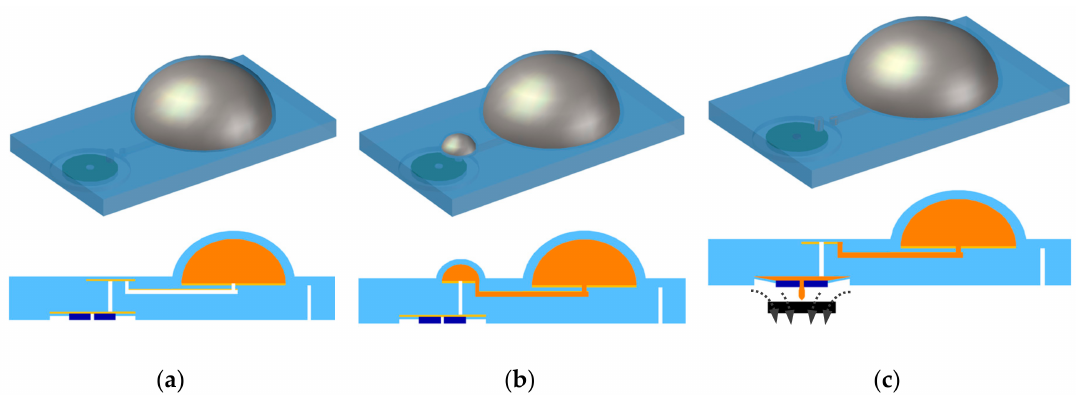
Figure 1. Schematic of the proposed drug delivery device. ( a ) Fluidic drug substances are injected into the device through a syringe. The primary chamber inflates. ( b ) The secondary chamber is subsequently inflated as the substances from the primary chamber travel through the microchannel. ( c ) The magnetic polydimethylsiloxane (PDMS) membrane is deflected using a permanent magnet releasing the secondary chamber’s volume first. The magnet is removed and the valve is closed. ( b ) and ( c ) procedures can be repeated until the primary chamber reaches